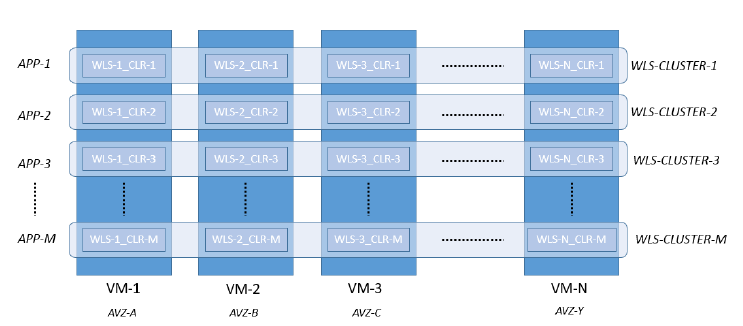
Fig. 1. Deployment model of a WebLogic domain on virtual machines